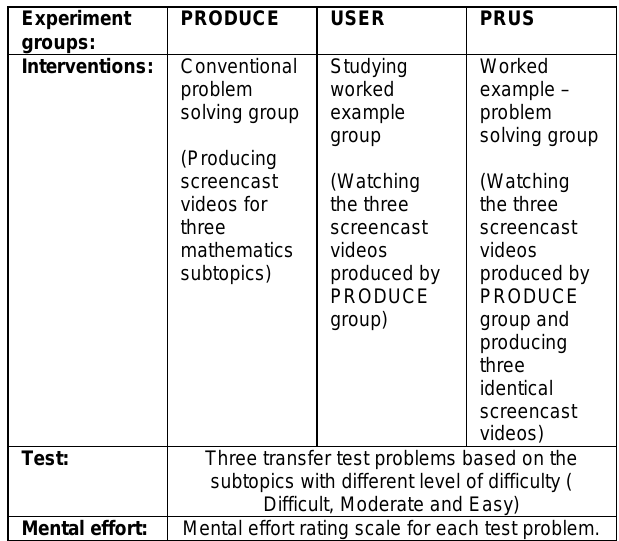
Figure 1. Experim ental Groups, Interventions and